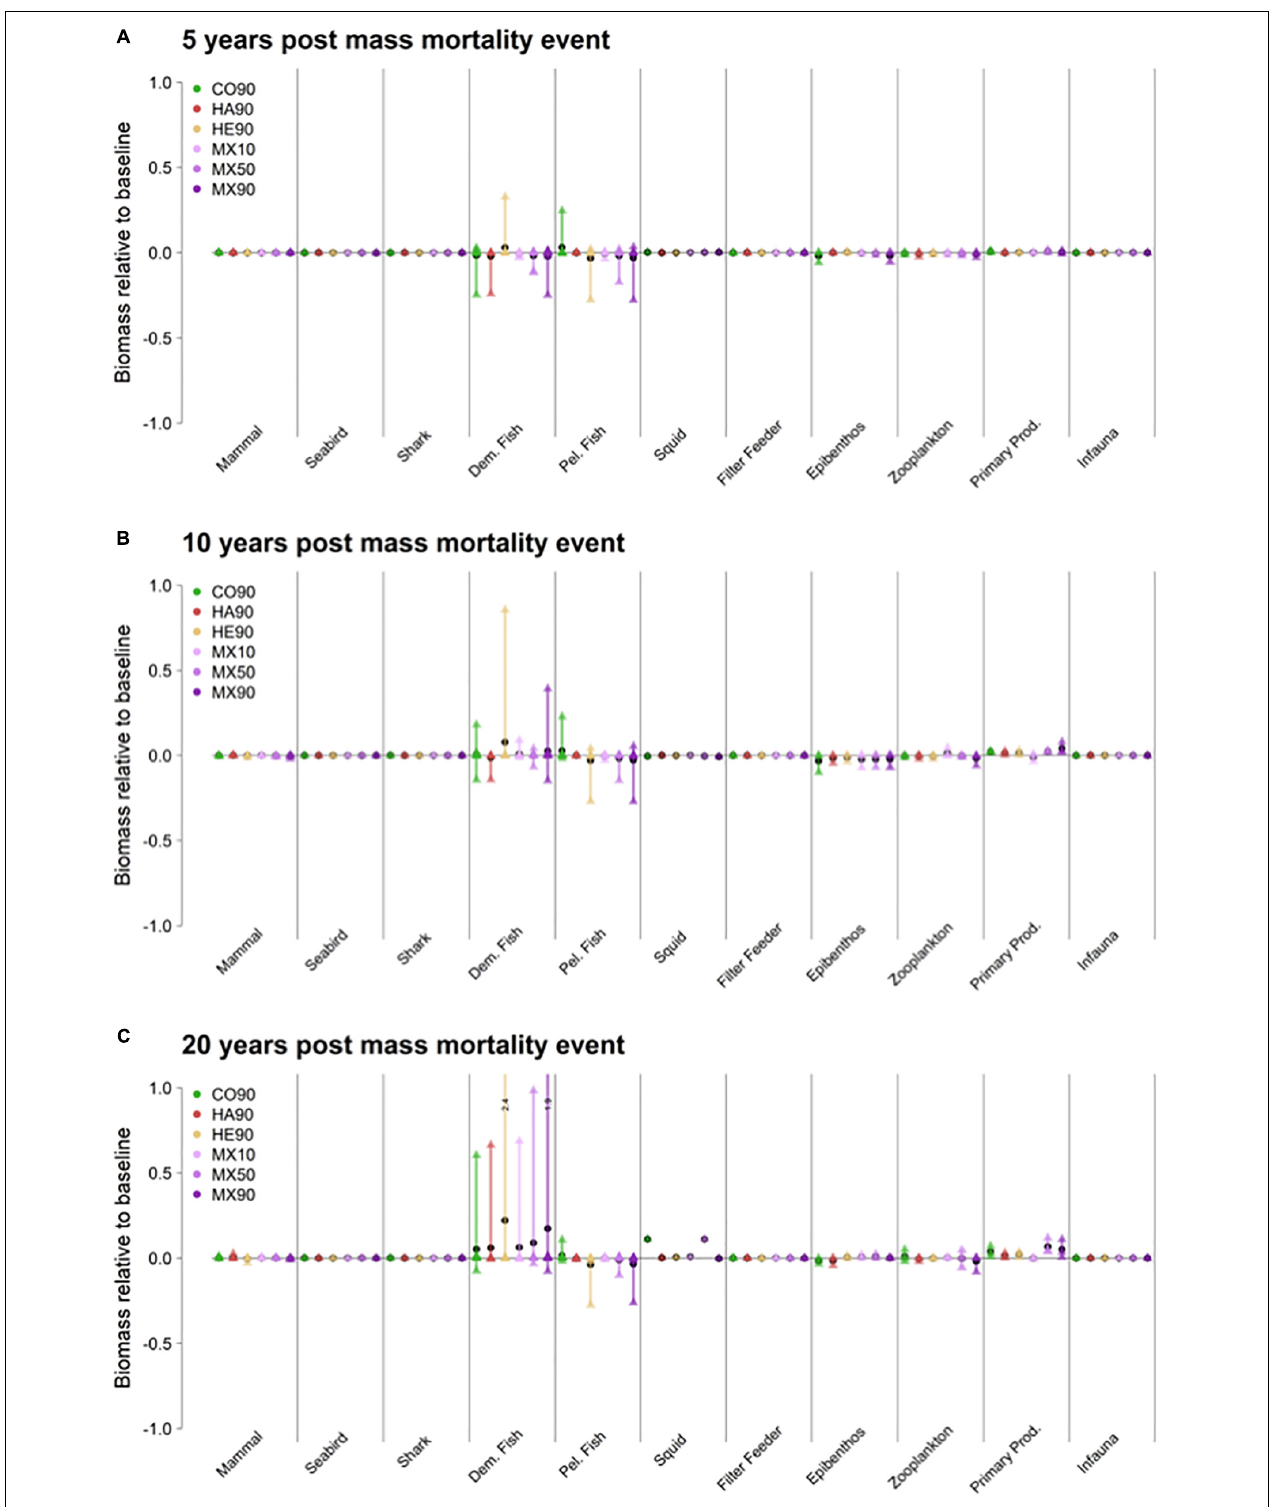
FIGURE 4 | Averages of the responses of the 11 trophic guilds to mass mortality events reducing the survival of fish egg and larvae of Northeast Arctic cod ( Gadus morhua ), Northeast Arctic haddock ( Melanogrammus aeglefinus ) and Norwegian Spring Spawning herring ( Clupea harengus) over the first 5 (A) , 10 (B) and 20 years (C) post the mass mortality event (oil spill) modeled using the NoBa Atlantis ecosystem model. The colored bars cover the range of responses from minimum to maximum, the black circles are the mean response within a guild, while the triangles show the response of individual species (or species groups).